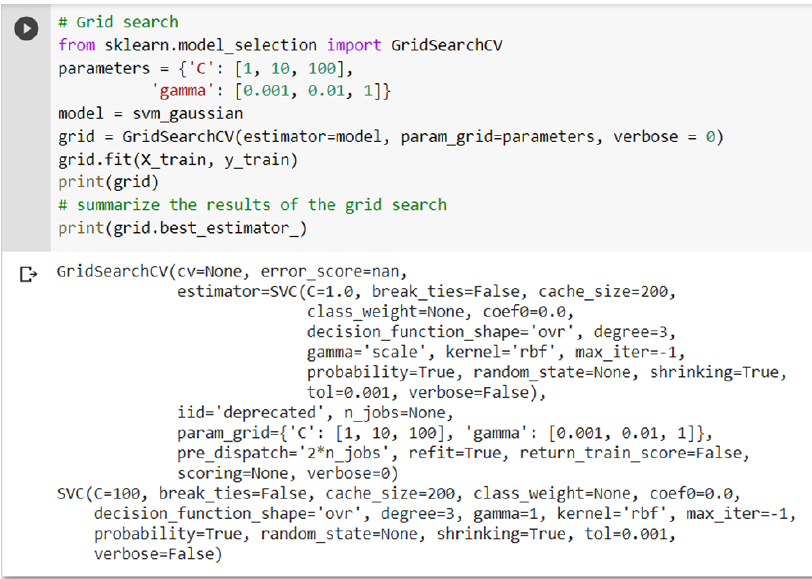
Fig. 5. Grid search for SVM parameter